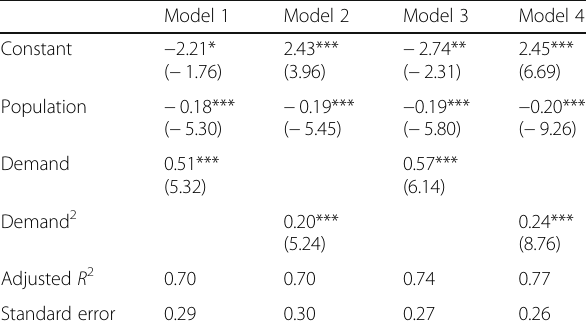
Table 1 Estimation results, explaining trade openness in